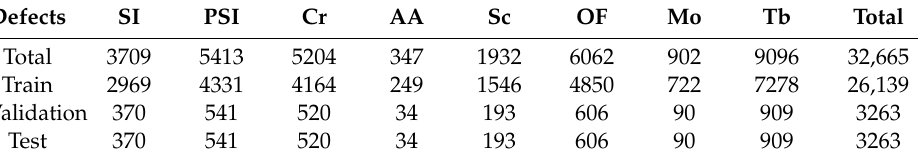
Table 2. Specific of each type of defect used in the classification experiment.